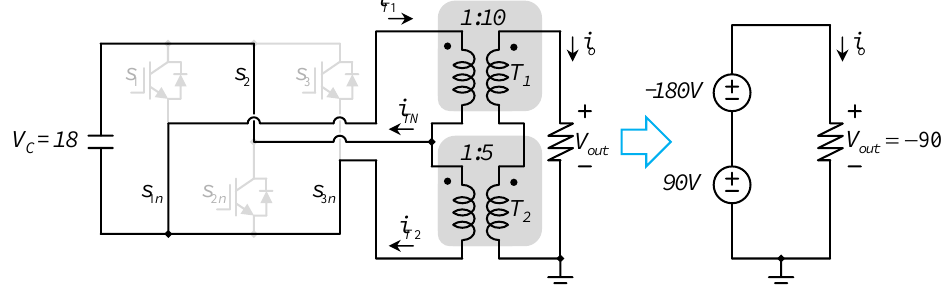
Figure 8. Equivalent circuit when s 1 = 0, s 2 = 1, and s 3 = 0 ( s 1 n = 1, s 2 n = 0, and s 3 n = 1).